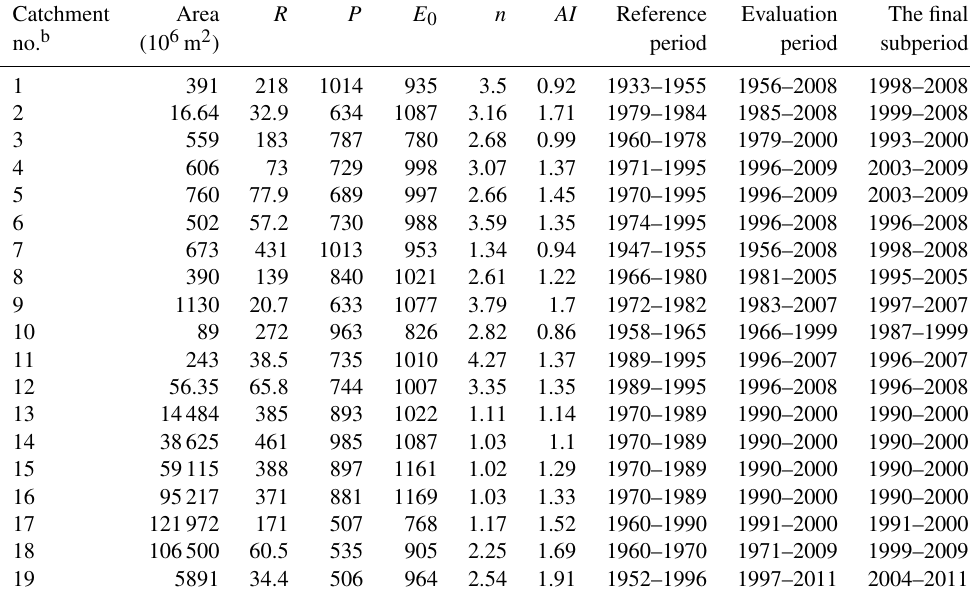
Table 1. Summary of the long-term hydrometeorological characteristics of the selected catchments a